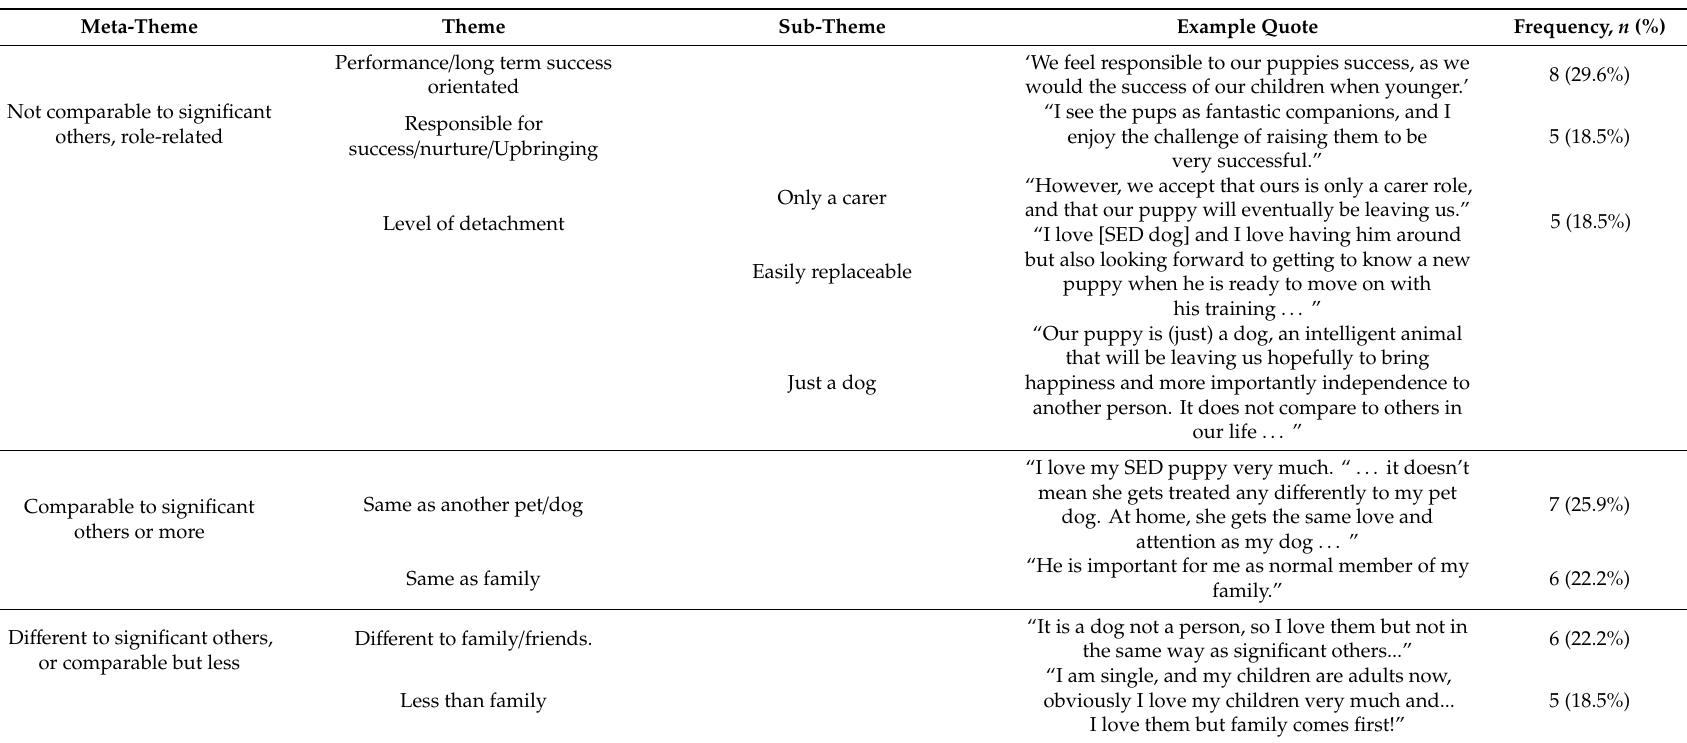
Table 11. SED carer descriptions of their feelings towards SED dog compared towards significant others ( n =